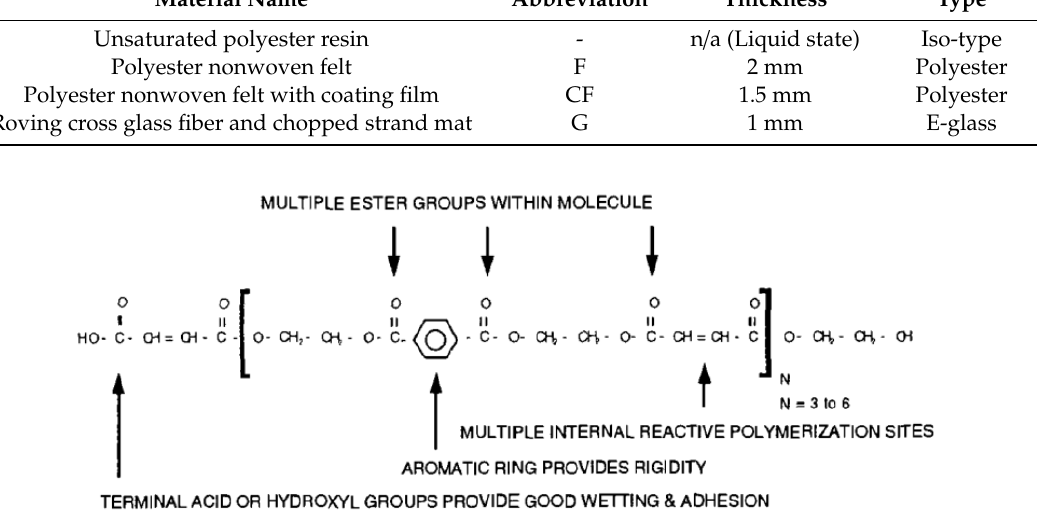
Figure 2. Generic structure of isophthalic polyester resin [20].